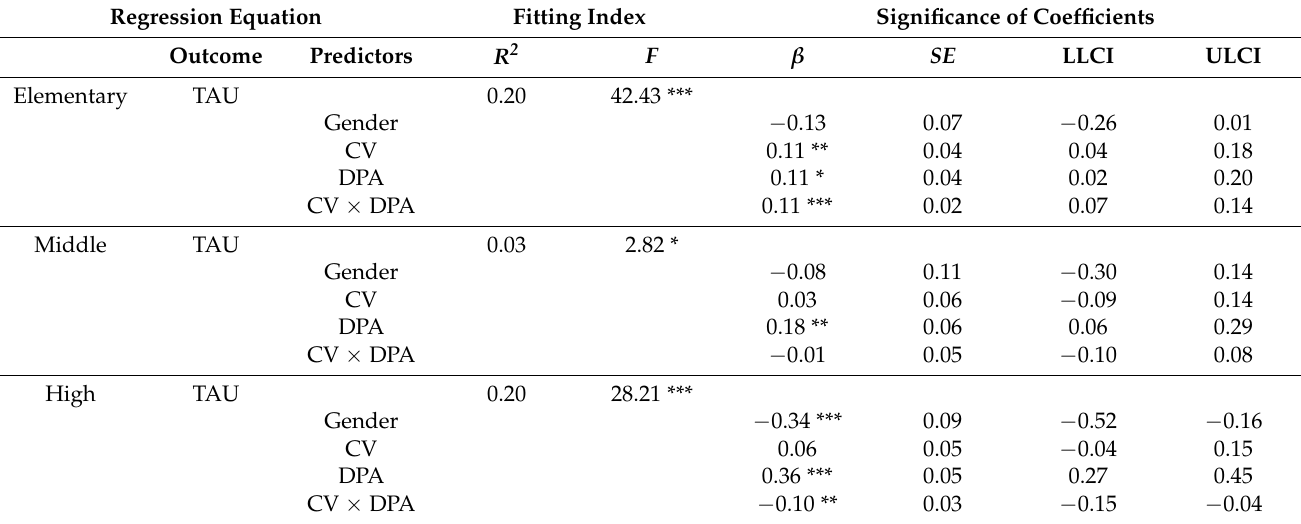
Table 2. Testing the moderated effect among elementary, middle, and high school students. Regression